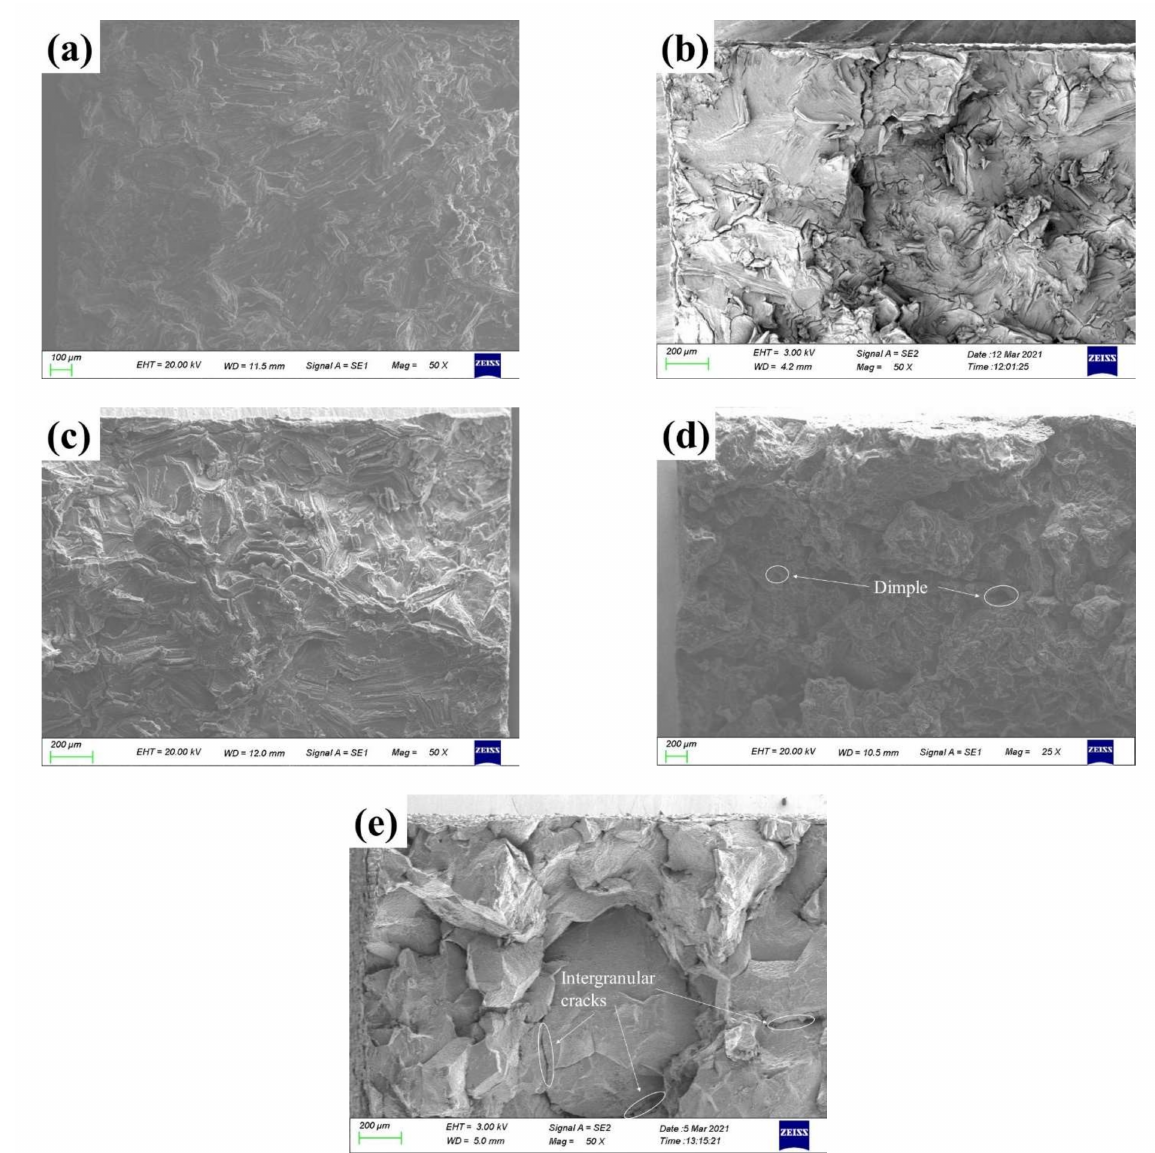
Figure 6. Fracture surfaces of 3PB specimens for LiH at: ( a ) RT; ( b ) 200 ◦ C; ( c ) 300 ◦ C; ( d ) 500 ◦ C; ( e ) 600 ◦